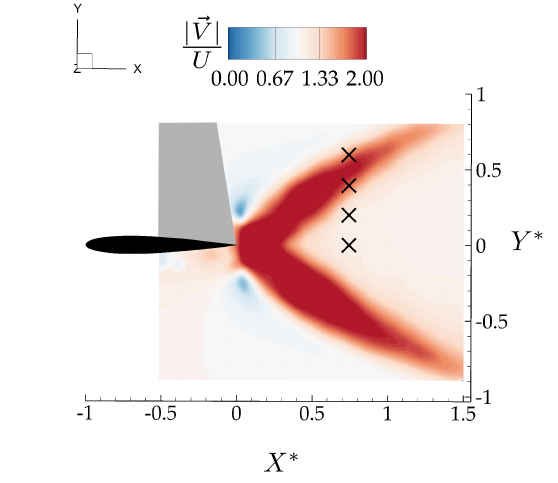
Figure 8. Locations of the leading edge of the follower foil ( x markers) relative to the time-averaged velocity jets from the flowfield of the isolated